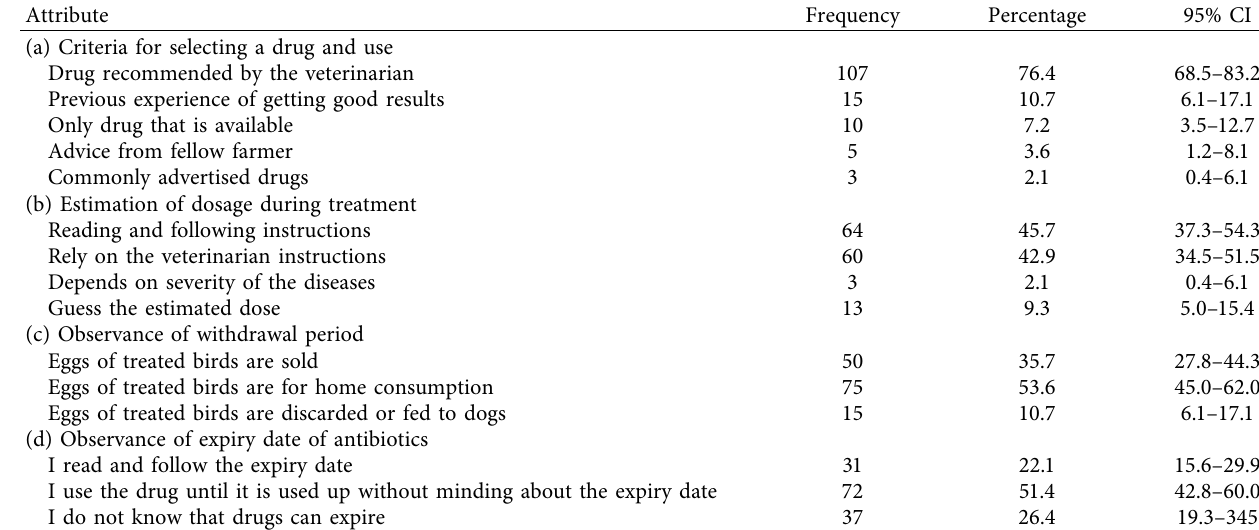
Table 4: Antibiotic use practices and associated public health